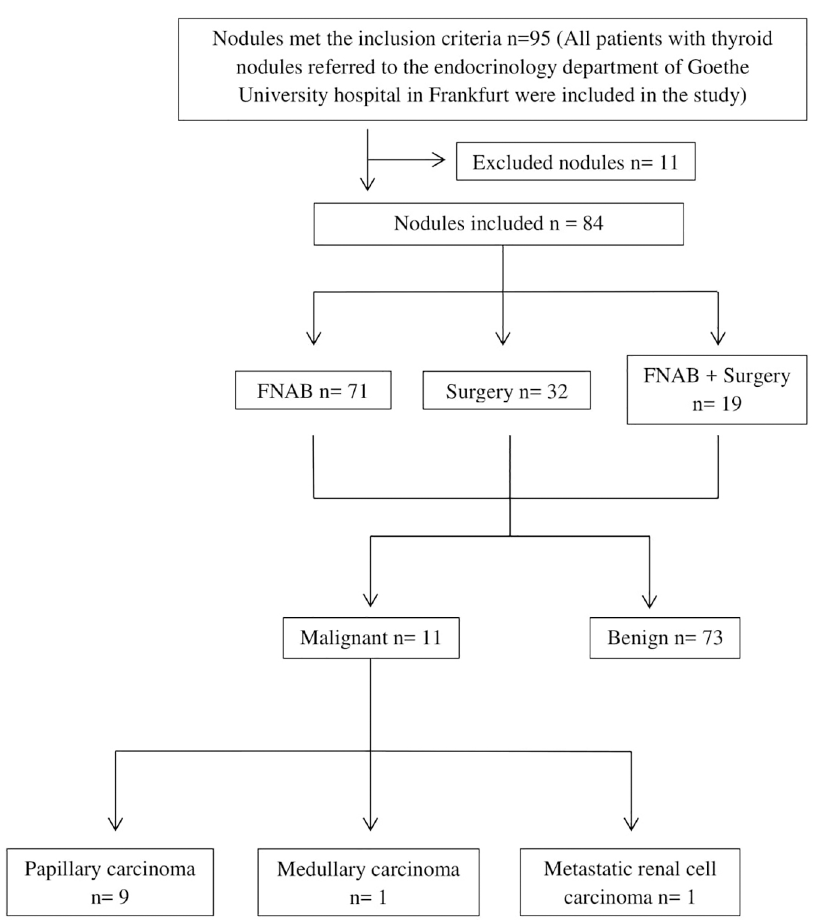
Fig 4. Number of nodules that underwent FNAB and/or surgery, number of benign and malignant thyroid nodules and types of thyroid cancer.